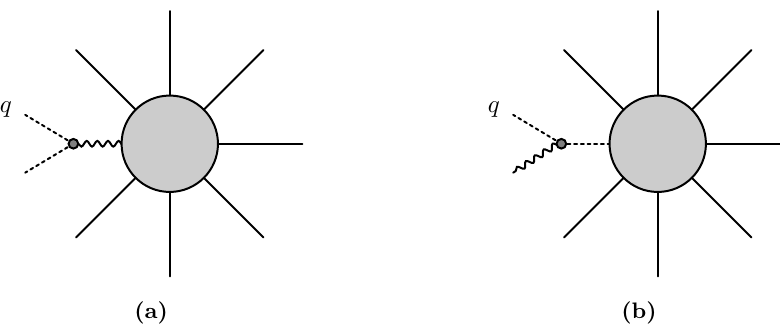
Figure 2. Diagrammatic interpretation of the terms in (4.18). Dilatons are represented by dashed lines while gravitons correspond to wavy lines. The soft particle carries momentum q